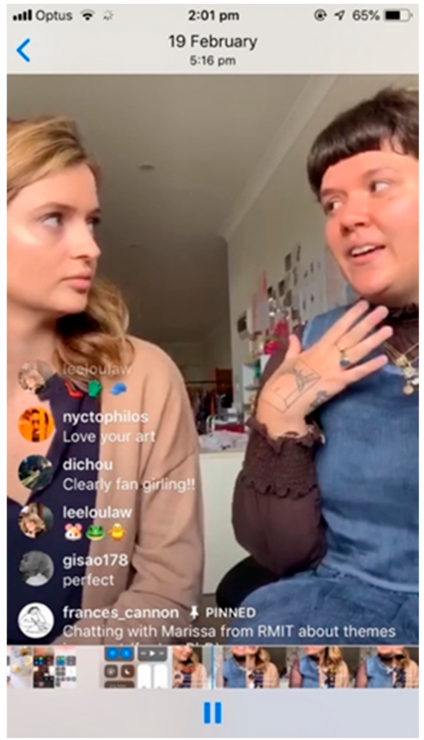
Figure 10. Digital Di ff raction. RMIT University Human Ethics Clearance Number